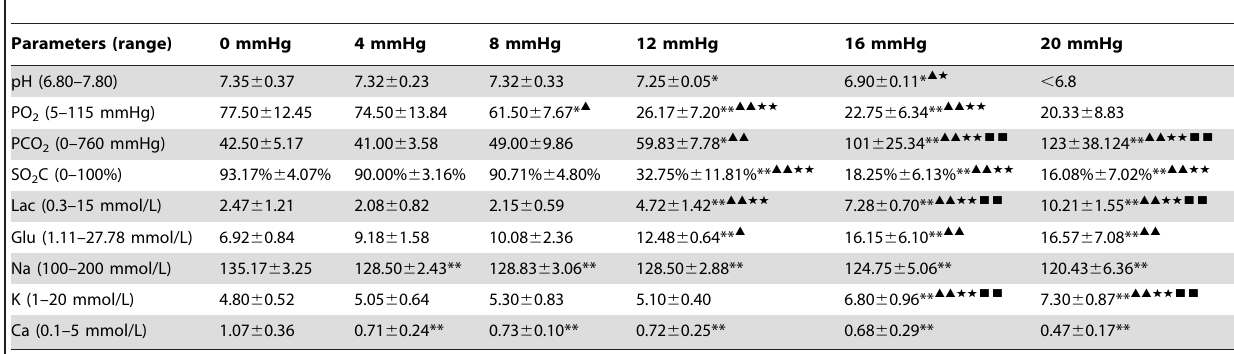
Table 2. Effects of the different grades of nitrogen pneumoperitoneum on arterial blood gas parameters.